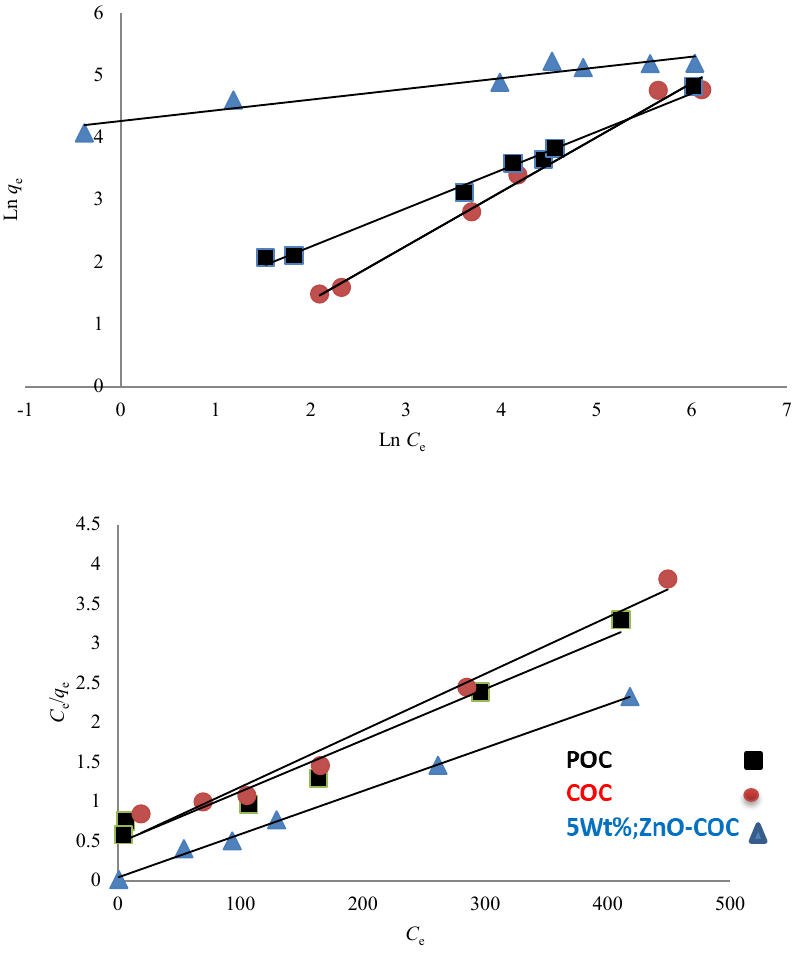
Fig. 9 . Isotherms of MB adsorption applying (A) Freundlich and (B) Langmuir models of (■) purified clay (● ) calcined clay and ( ▲ ) impregnated clay (pH = 6.8; m = 0.025 g; V = 50 mL; T = 24 °C). According to these results, the Langmuir and Freundlich models have obtained all the correlation ( R 2 ) greater than 0.92, which revealed that the sorption isotherm of methylene bleu on clays can may be viable to both models, Freundlich and Langmuir. However, Table 5 shows that the Langmuir model is the suitable isotherm for the adsorption of MB on the three samples. Langmuir model fitted well the adsorption isotherms which indicates the homogeneous distribution of active sites and the monolayer coverage on the adsorbent [42], [46]. The constant “ n ” in the Freundlich model is a necessary parameter; it indicates the type of